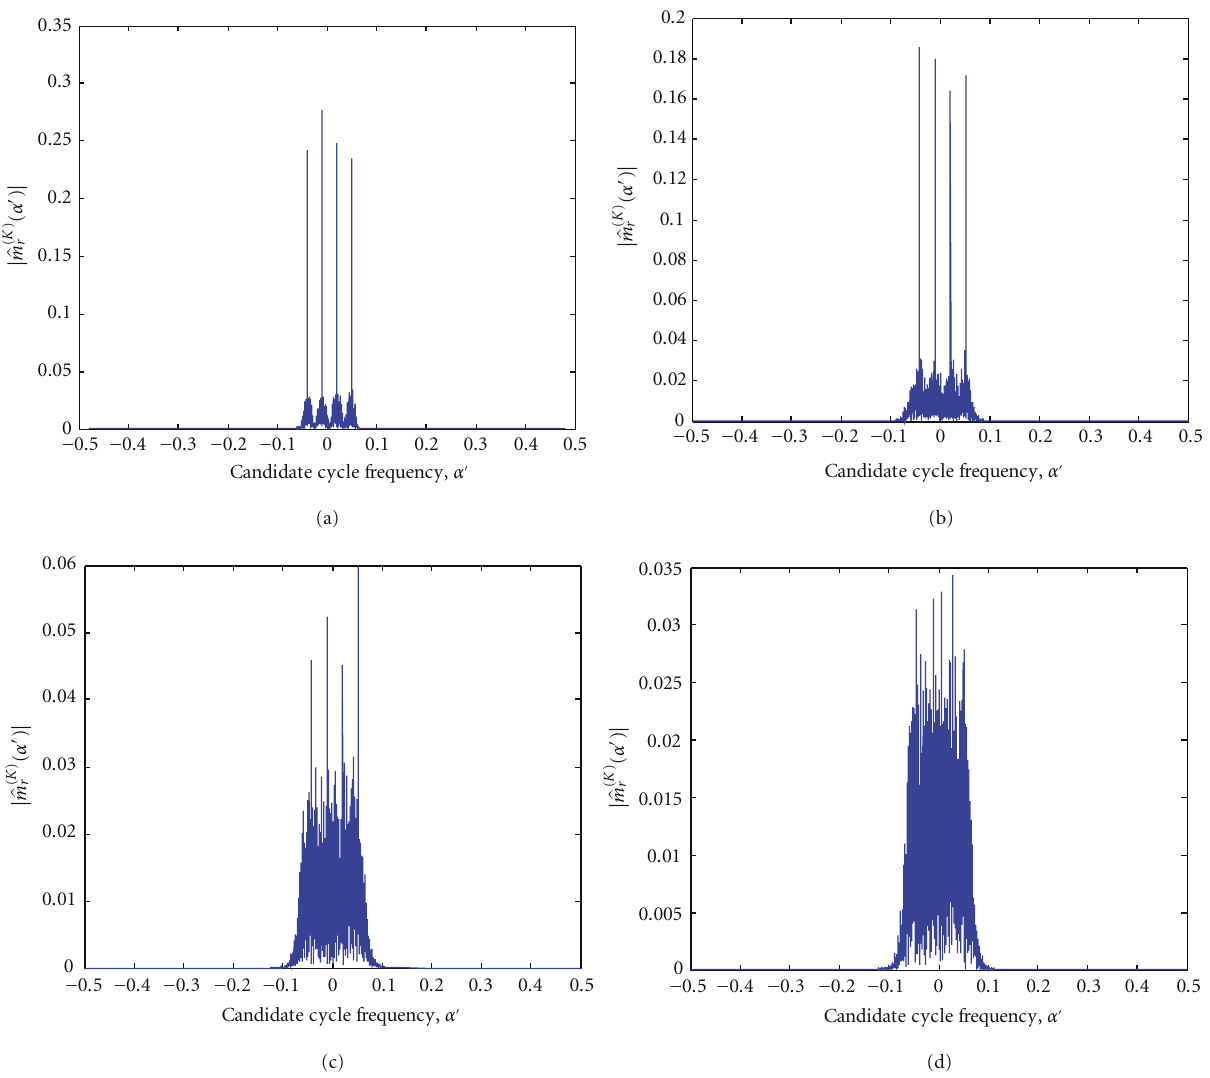
Figure 2: The magnitudes of the first-order estimated CM of the 4-FSK signal, at candidate CFs α (cid:8) , α (cid:8) ∈ [ − 1 / 2,1 / 2), for (a) 20dB SNR, (b) 0dB SNR, (c) − 13 dB SNR, and (d) − 20 dB